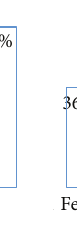
Figure 2: Prevalence of malaria according to patients’ gender using microscopy. Table 2: 2 × 2 contingency table for assessing the RDT’s perfor- mance.